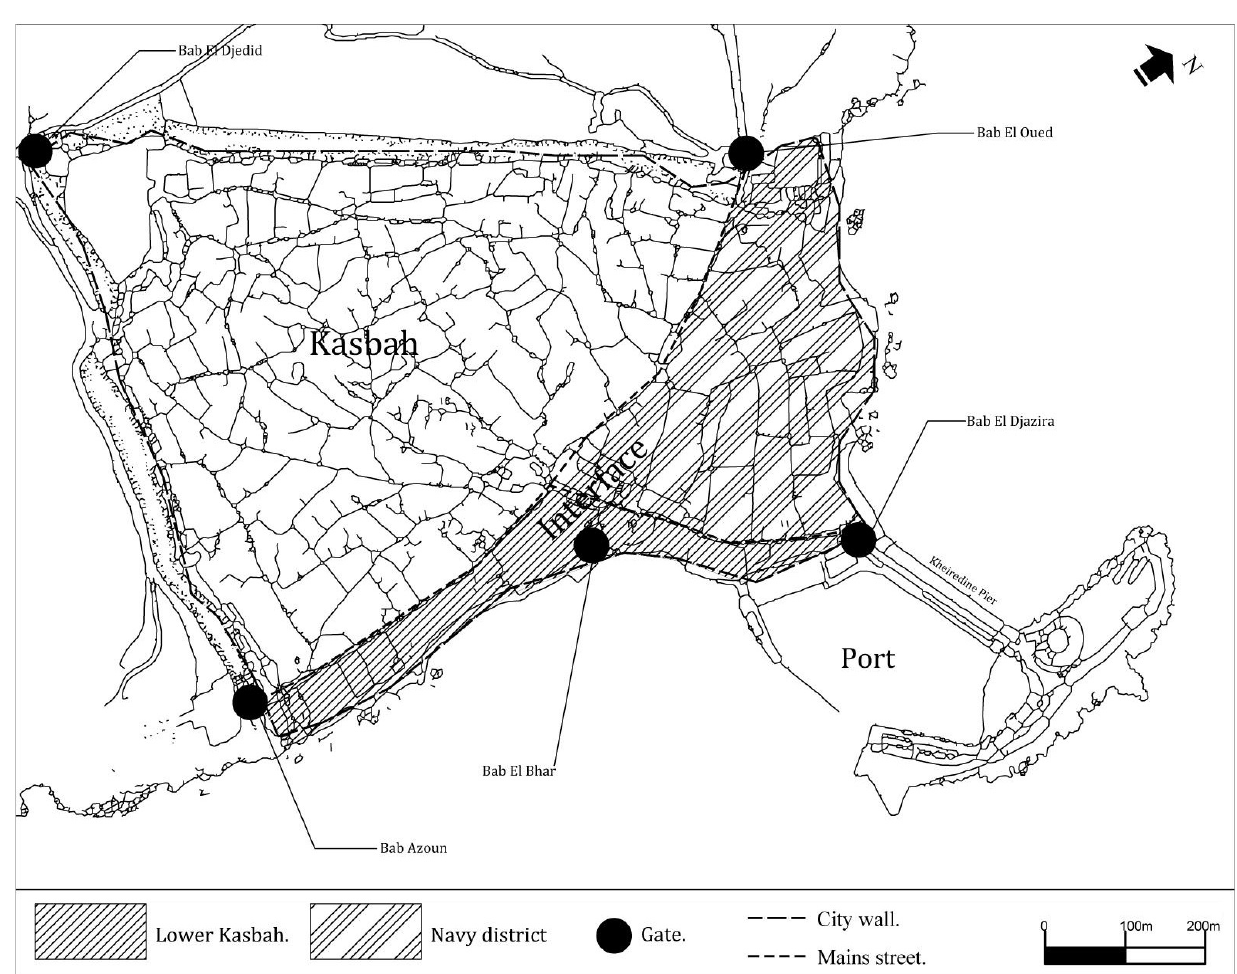
Figure 4. Map (1830) of the divisions of the port‐city interface in relation to the principal city gates. Source: Produced by the authors, based on Lespès (1921) and Missoum